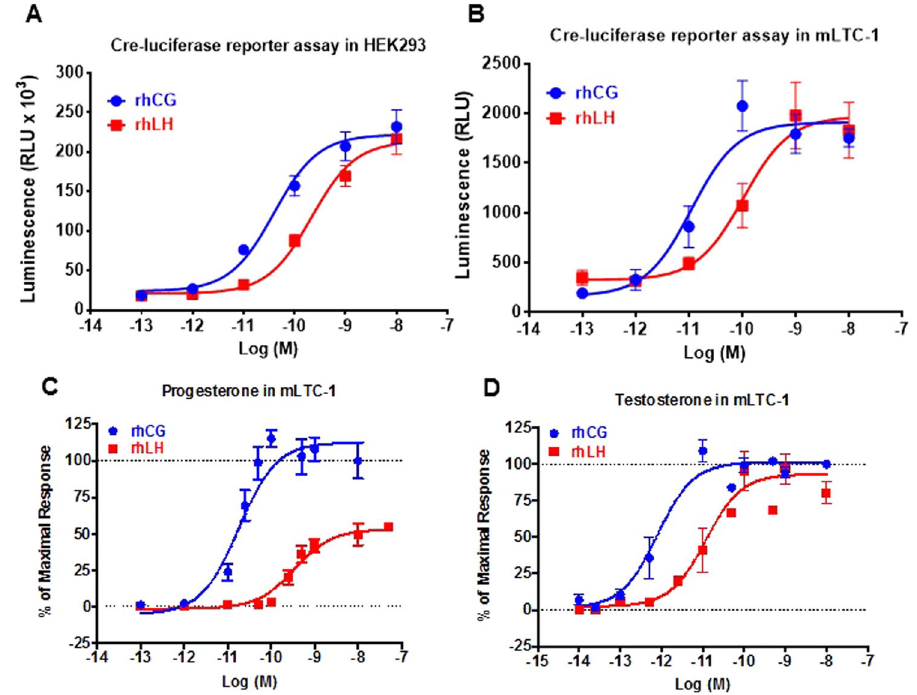
Figure 3. LH/CGR-promoted integrated responses in HEK293 and mLTC-1 cells. ( A ) HEK293 transiently co-transfected with plasmids coding for LH/CGR and pSOM-Luc reporter gene were stimulated 6 hours with increasing doses of rhCG and rhLH before luciferase activity was measured ( A ). mLTC-1 cells transiently transfected with plasmid coding pSOM-Luc reporter gene were stimulated 6 hours with increasing doses of rhCG and rhLH before luciferase activity was measured ( B ). For LHR-mediated steroid production, mLTC-1 cells were stimulated 3 hours with increasing doses of rhCG and rhLH and the supernatant levels of progesterone ( C ) and testosterone ( D ) were measured by ELISA or HTRF, respectively. Data are means ± SEM of 3–5 independent experiments performed in single or